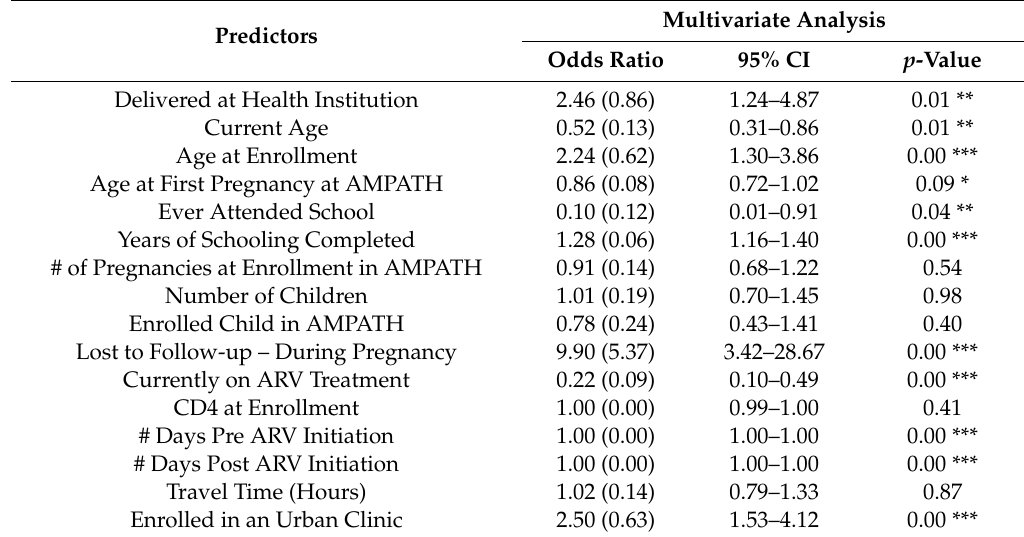
Table 3. Predictors of Health Insurance Enrollment among HIV positive Pregnant